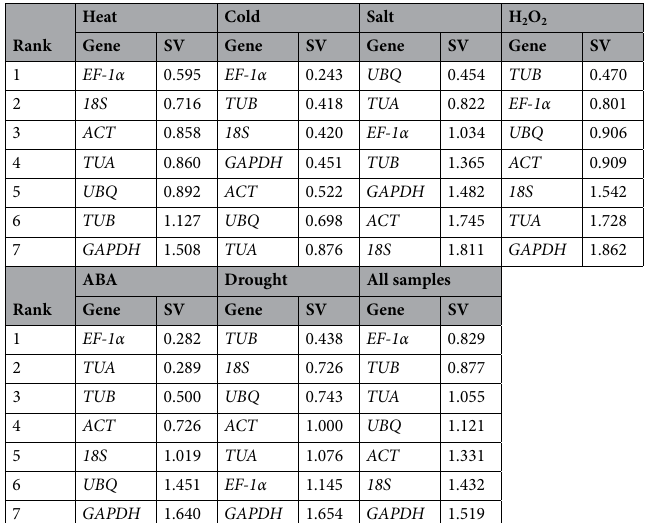
Table 2. Expression stability of seven reference genes following various treatments based on a NormFinder